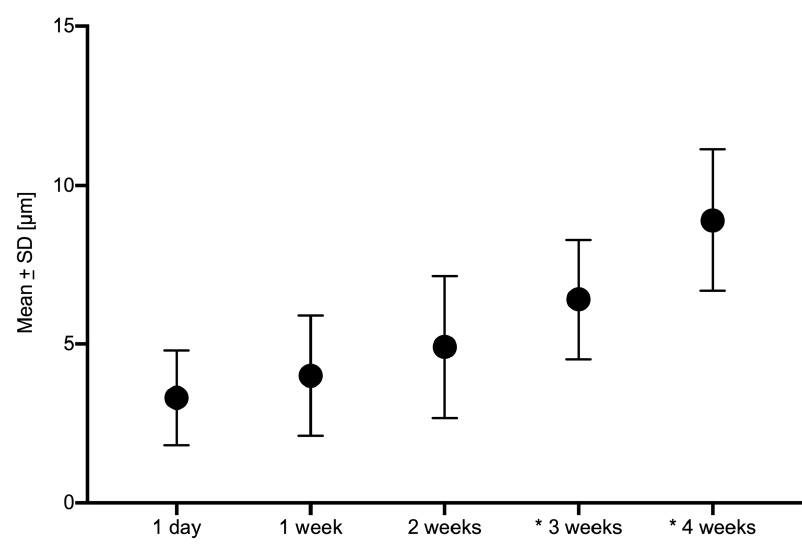
Figure 3. Deviation analysis of the tested 3D-printed models after defined aging represented by the five timepoints for mean values including standard deviations (SD) in micrometer (µm) with significant differences after * 3 weeks ( p = 0.0008) and * 4 weeks ( p < 0.0001).